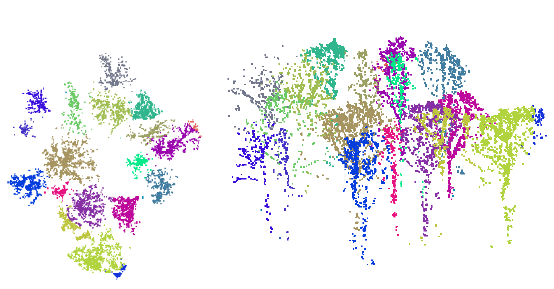
Figure 4. Top and the front of Plot D segmented using Method 4 (calibrated), with each separate tree assigned a random colour.